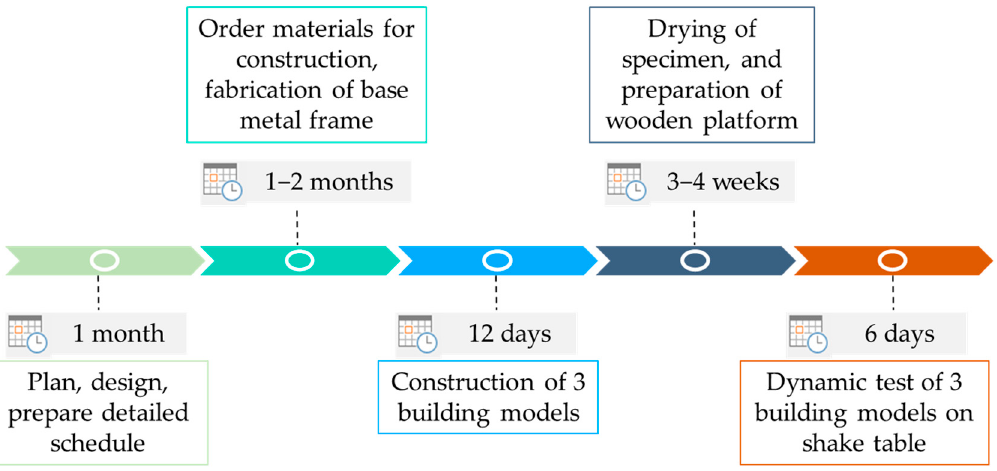
Figure 1. Timelines of the planning, construction, and execution of the dynamic tests.